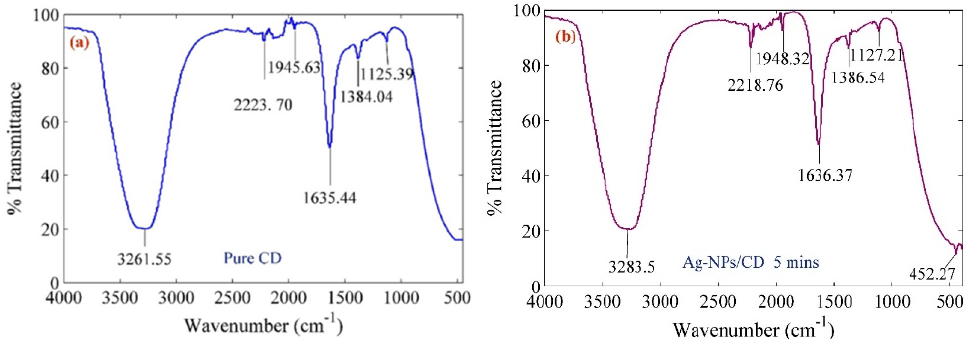
Figure 1. FTIR spectrum of ( a ) pure CD (before ablation the Ag plate) ( b ) Ag–NPs/CD nanocomposite at 5 min ablation time.